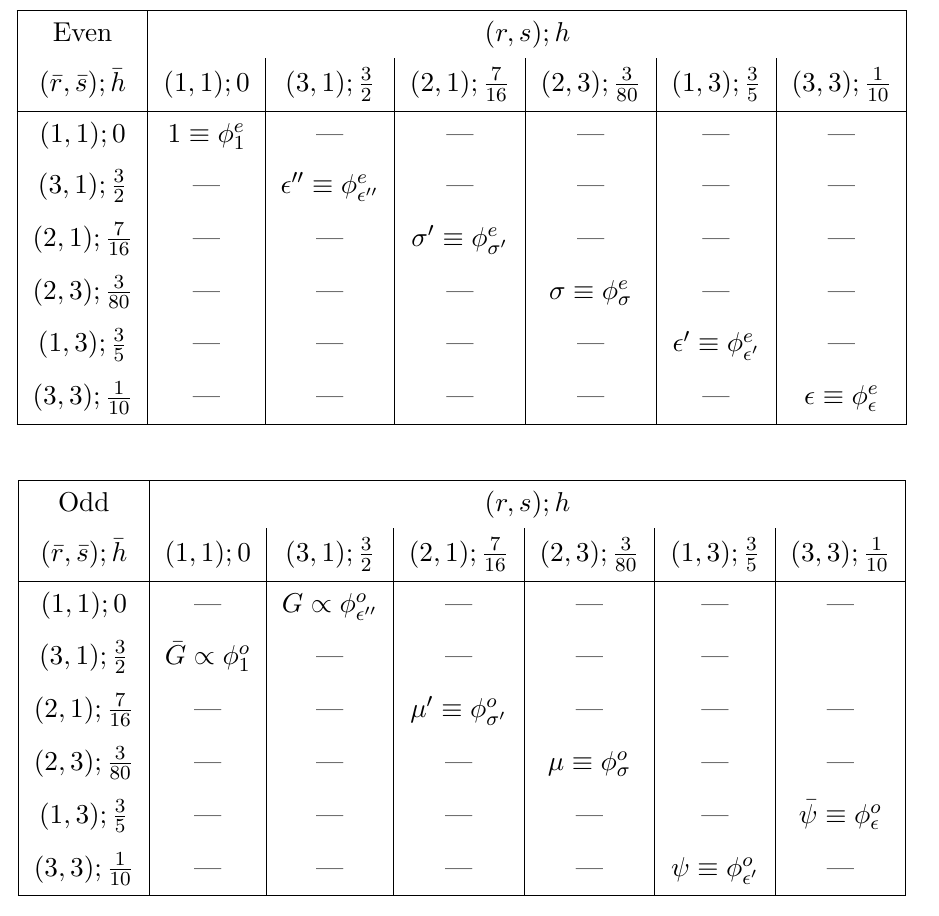
Table 21 . The odd and even sectors of the bulk tri-critical Ising model.